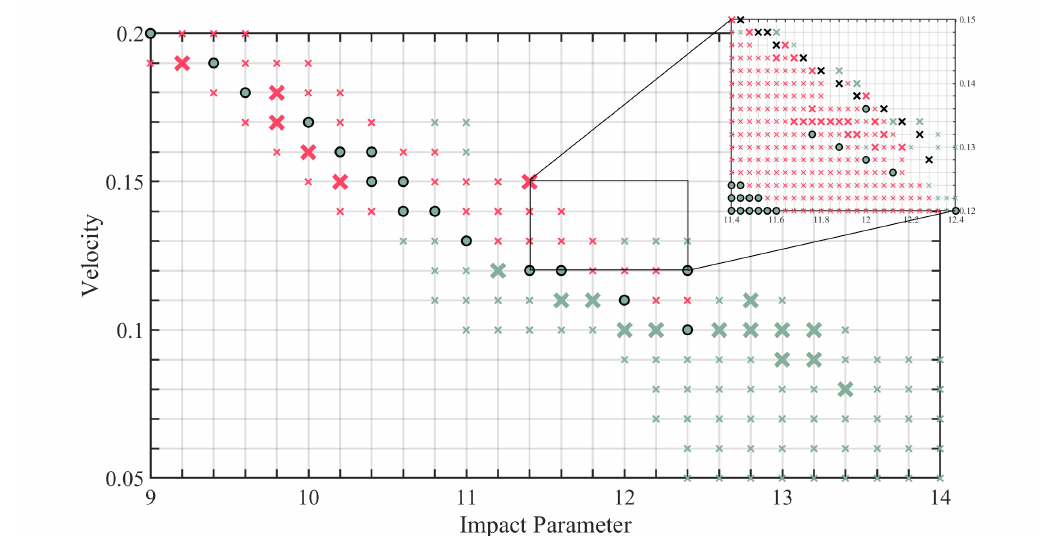
Figure 14 . Parameter space where CSQs can form for a non-head-on collision between a Q-ball and an anti-Q-ball. The horizontal axis is the impact parameter between the centers of the Q-ball and anti-Q-ball, and the vertical axis is the initial velocities of the two balls. The scattering results are shown in figure 15: (a) two balls passing through, (b) two CSQs (green crosses), (c) one CSQs and two simple Q-balls (red crosses), (d) three CSQs (green dots), (e) one CSQ (black crosses). Smaller crosses mean that the resulting CSQs have noticeably less charges. The frequencies of the Q-ball and the anti-Q-ball are 1 . 0 and − 1 . 0 respectively, and the initial positions of the two balls are at x = ± ImpactParameter / 2 and y = ± 10